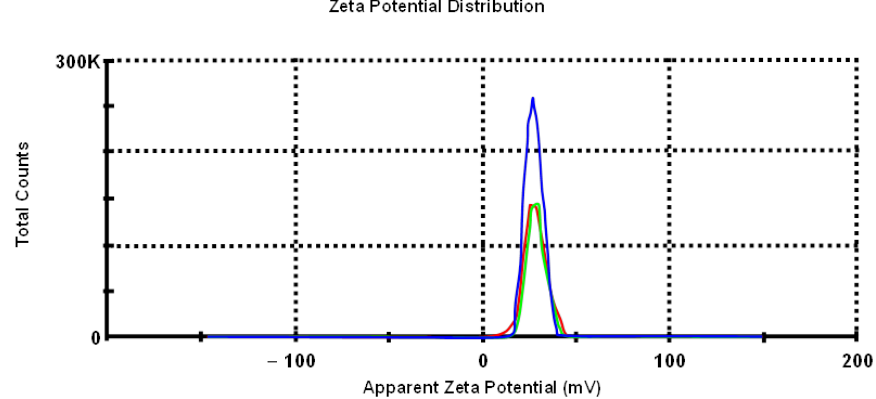
Figure 2. Zeta potential measurements (st. dev. –4.34).